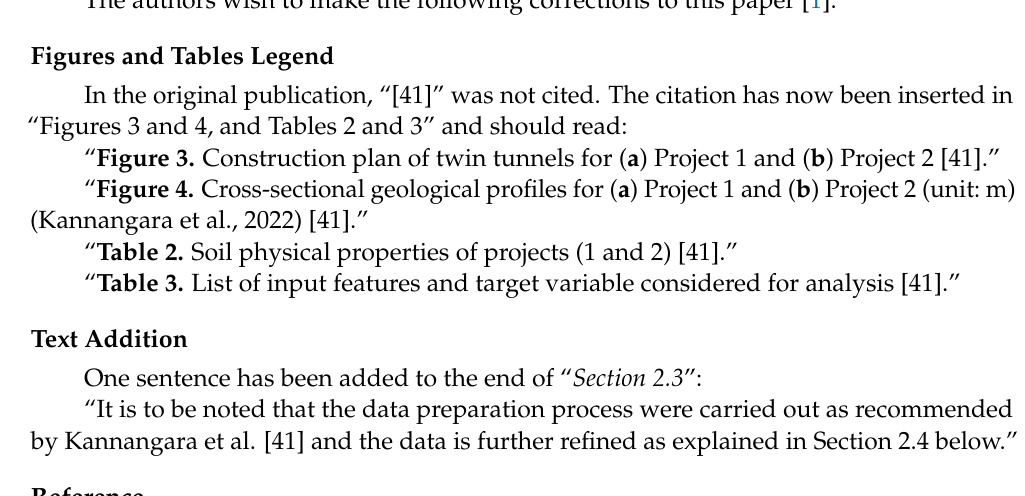
“ Figure 3. Construction plan of twin tunnels for ( a ) Project 1 and ( b ) Project 2 [41].” “ Figure 4. Cross-sectional geological profiles for ( a ) Project 1 and ( b ) Project 2 (unit: m) (Kannangara et al., 2022) [41].” “ Table 2. Soil physical properties of projects (1 and 2) [41].” “ Table 3. List of input features and target variable considered for analysis